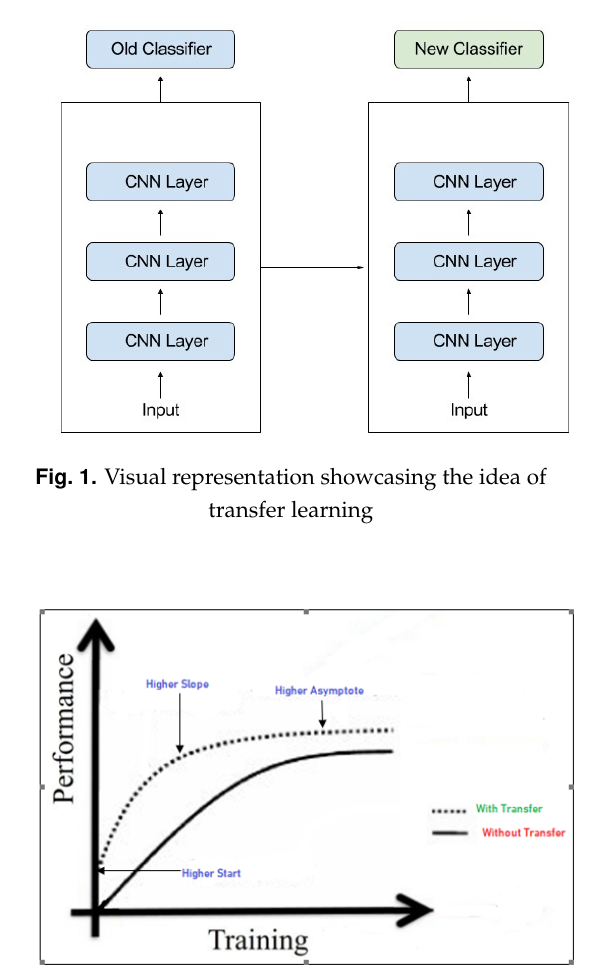
Fig. 2. Metrics related to applications incorporating transfer learning tend to show higher convergence rate with a higher slope and a higher